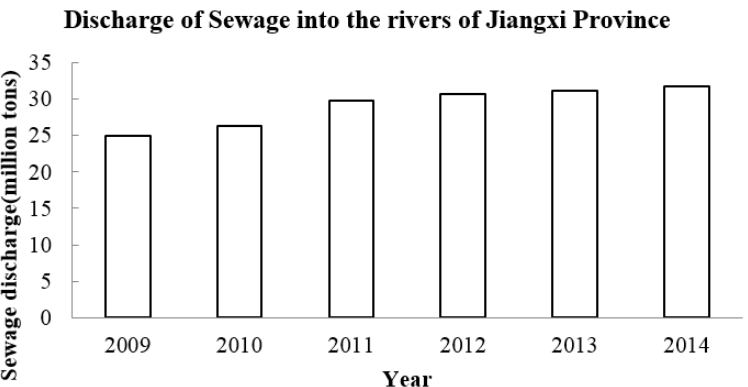
Figure 7. Annual variations in the discharge of sewage into the rivers of Jiangxi Province.